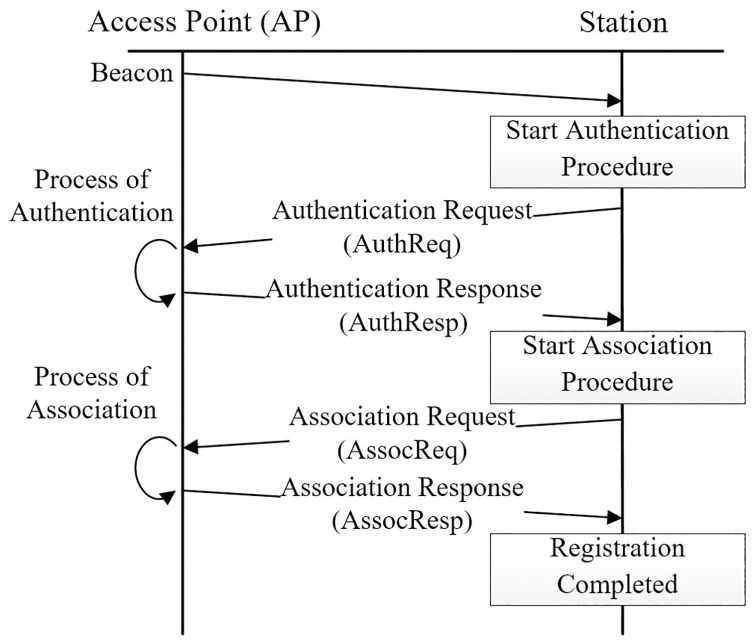
IEEE 802.11ah registration procedure [14].